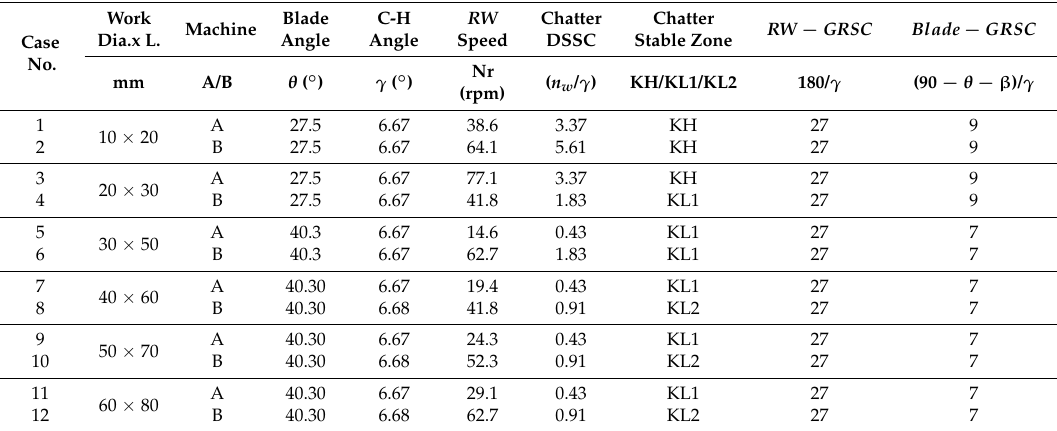
Table 5. The optimum setup conditions provided by the Opt-Setup Master for the grinding of cylindrical workpieces with different machines A and